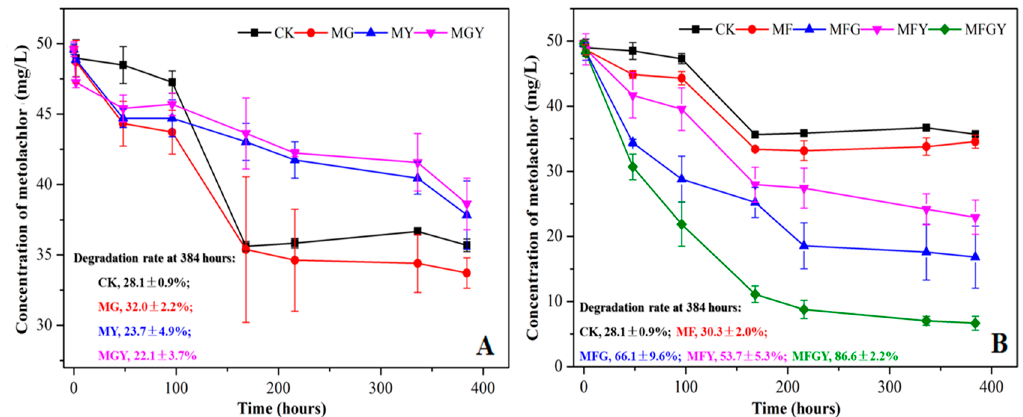
Figure 4. Degradation of metolachlor in different substrates: ( A ) Blank of MSM (Minimal salts medium) and MSM coupled with different nutrients; ( B ) Co-metabolized substrates inoculated with strain MET-F-1 and added with different nutrients. CK, only MSM; MG, MSM added with 0.2% glucose; MY, MSM added with 0.2% yeast extract; MGY, MSM added with 0.1% glucose plus 0.1% yeast extract; MF, MSM inoculated with strain MET-F-1; MFG, MF added with 0.2% glucose; MFG, MF added with 0.2% yeast extract; MFGY, MF added with 0.1% glucose plus 0.1% yeast extract.